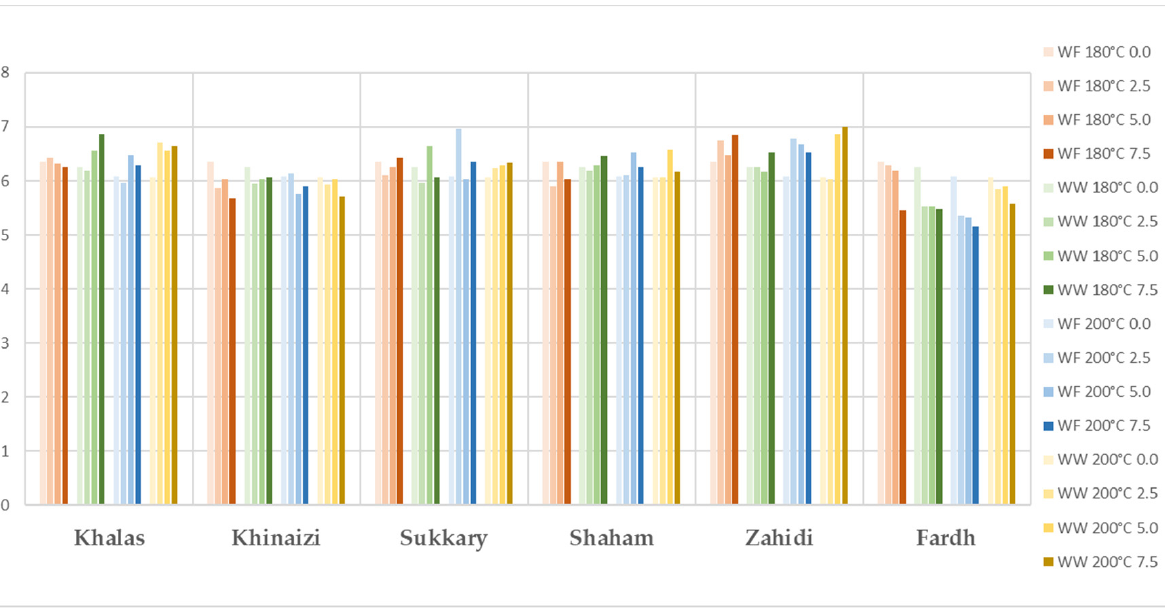
Figure 3. Texture evaluation for date seed composite cookies.